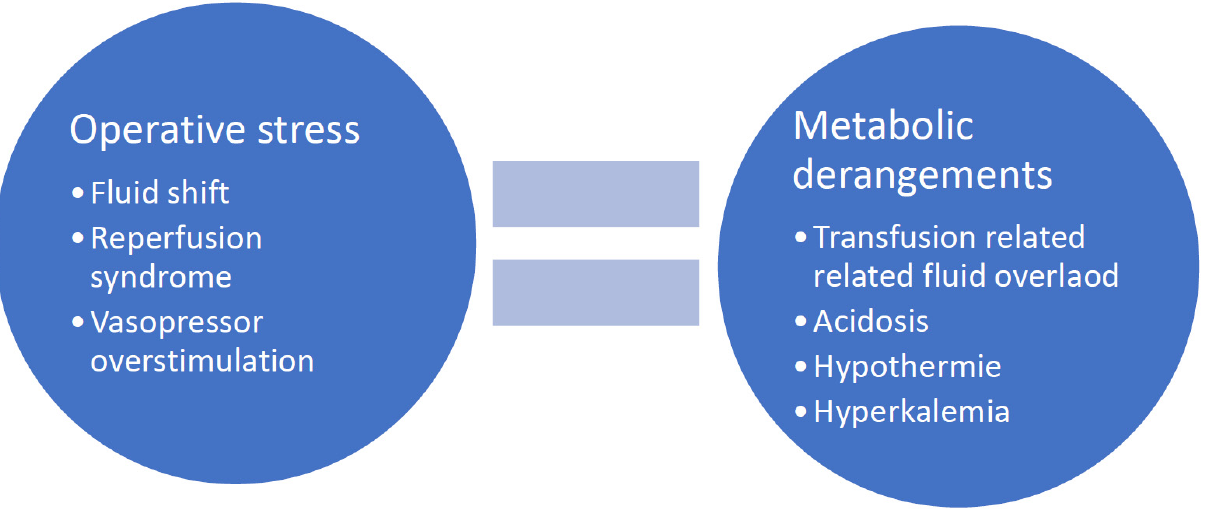
Figure 1. Common causes of postoperative cardiovascular disorder.